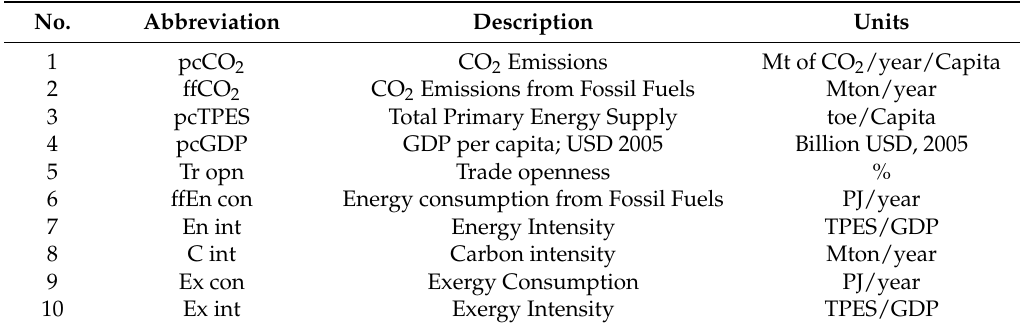
Table 2. Multivariable framework summary